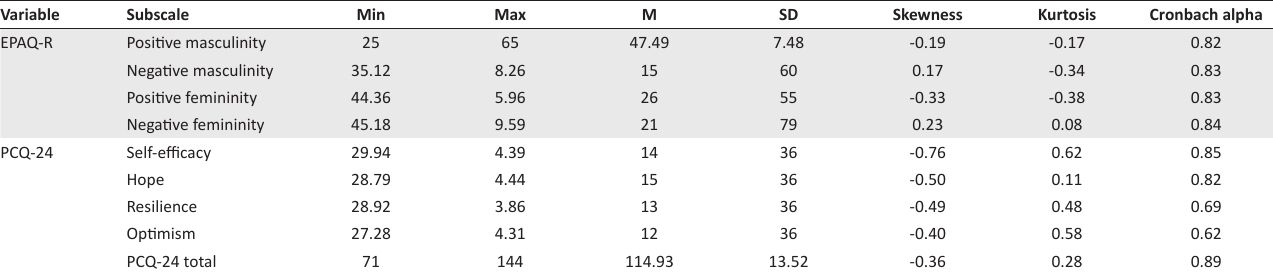
TABLE 2: Descriptive statistics for EPAQ-R and PCQ-24. Variable